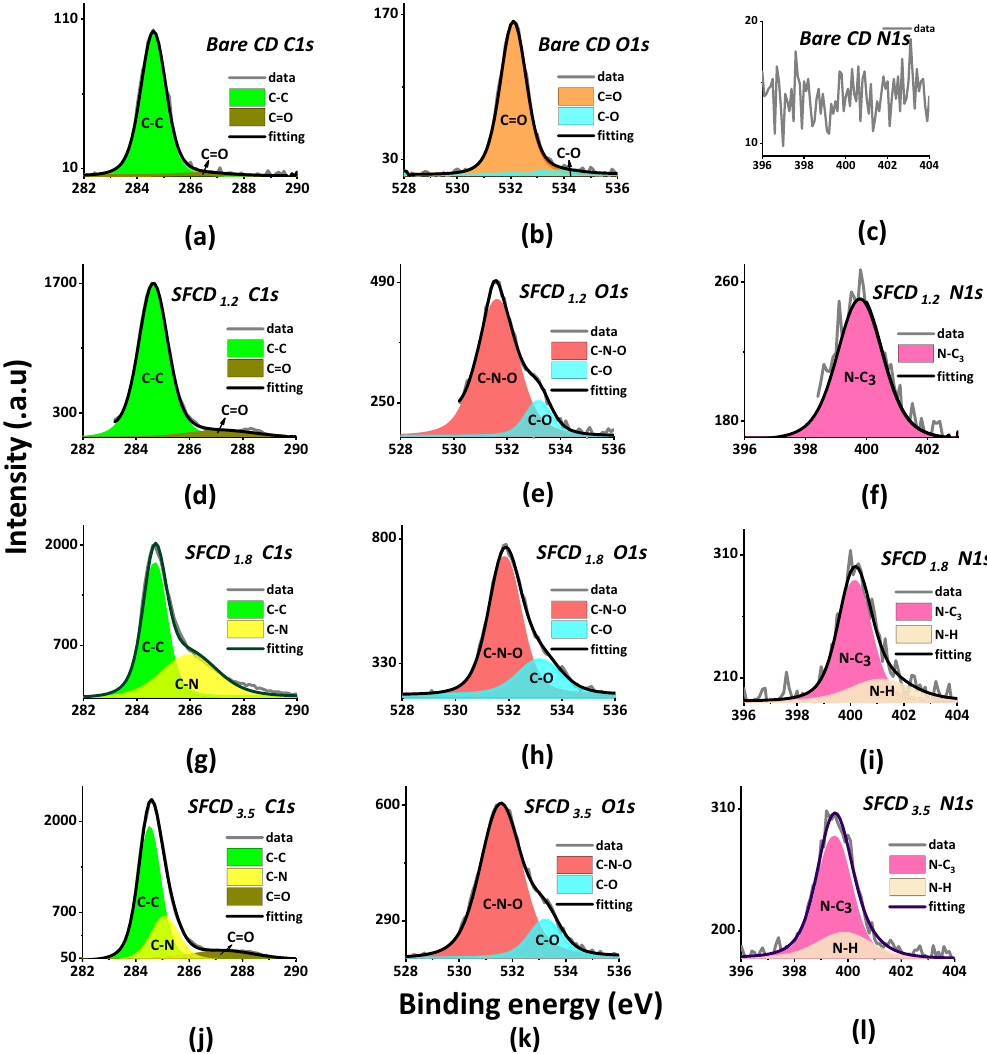
Figure 4. Further Deconvolution spectra of ( a – c ) C1 s , O1 s , N1 s spectra of bare CDs, ( d – f ) C1 s , O1 s , N1 s spectra of SFCD 1.2, ( g – i ) C1 s , O1 s , N1 s spectra of SFCD 1.8 , ( j – l ) C1 s , O1 s , N1 s spectra of SFCD 3.5 is plotted. Deconvolution of high resolution C1s spectrum of bare CDs and SFCDs show two peaks at 284.6 eV and 287 eV that corresponds to C=C and C=O bonds respectively. Peak at 285 eV in C1s spectra of SFCDs correspond to C− N bonding. Further deconvolution of O1s spectrum of bare CDs resolve two peaks centered at 532 eV and 533 eV that corresponds to C=O and C− O groups whereas SFCDs show slightly different O1s spectra with peak centered at 531.5 eV corresponds to C− N−O bond. Furthermore, Deconvoluted N1s spectra of SCFDs show peaks centered at 400 eV and 401 eV that correspond to N−C 3 and N−H